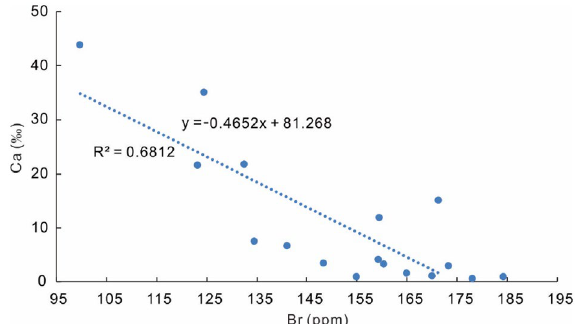
Figure 7. The relationship of Ca and Br contents of halite